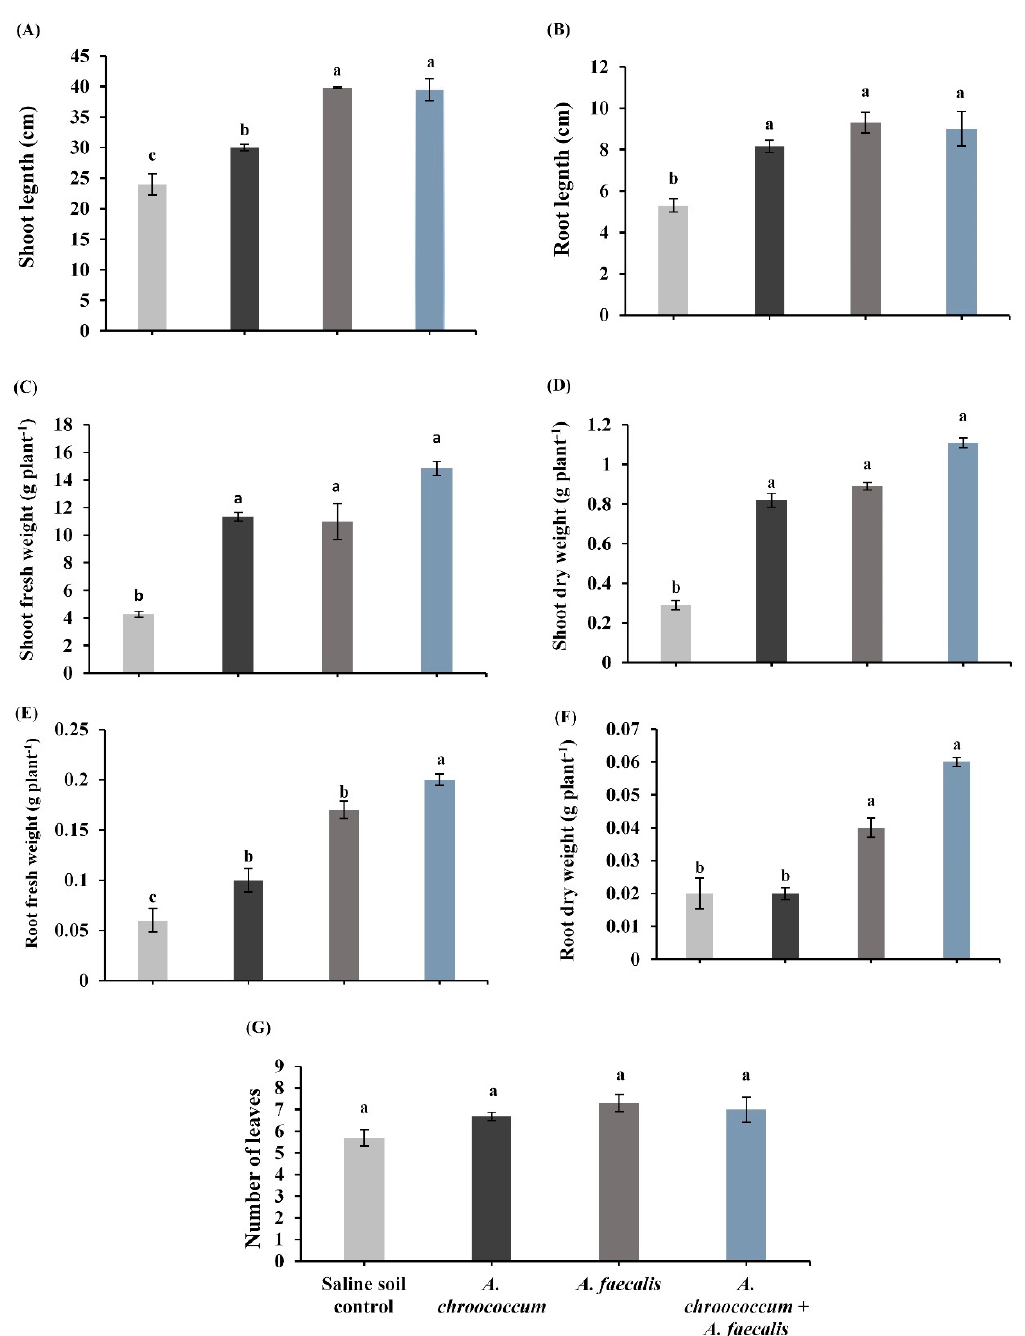
Figure 1. ( A ) shoot length; ( B ) root length; ( C ) shoot fresh weight; ( D ) shoot dry weight; ( E ) root fresh weight; ( F ) root dry weight; and ( G ) number of leaves of canola plant inoculated with Azotobacter chroococcum, Alcaligenes faecalis, and their co-inoculation under salinity-stress conditions. Bars show means of three independent replications (n = 3) ± standard error. Means with the same letter are not significantly different at p < 0.05.